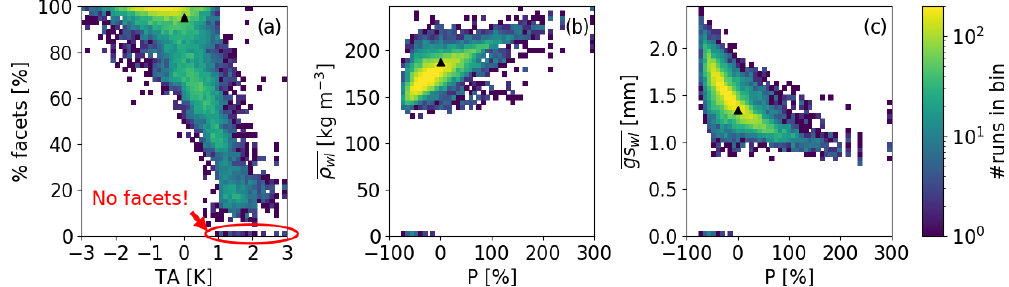
Figure 4. (a) Proportion of faceted layers within the weak layer with uncertainty in air temperature (TA) on 2 January 2017. (b) Density ( ρ wl ) and (c) grain size (gs wl ) of faceted layers with uncertainty in precipitation ( P ). Colors indicate the binned number of simulations. Triangles indicate the reference run. The red ellipse indicates simulations in which no weak layer formed.